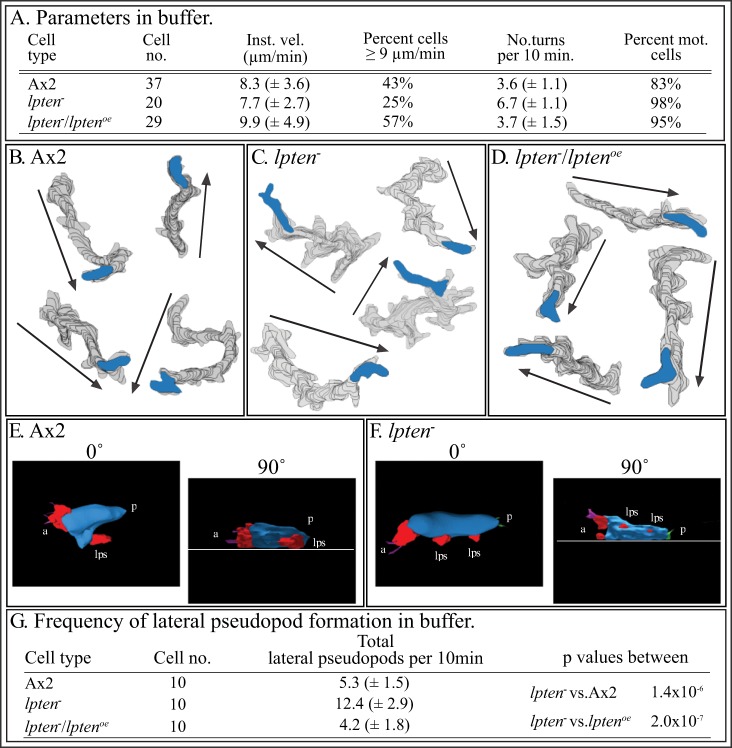

lpten− cells translocating in buffer in the absence of chemoattractant exhibit defects in velocity, turning and the suppression of lateral pseudopod formation.Cells were analyzed in a perfusion chamber through which buffer without attractant was pumped. A. 2D motility parameters of Ax2, lpten− and ptenA−/lptenoe cells assessed with 2D-DIAS software. B, C, D. 2D-DIAS reconstructions of cell perimeters to generate tracks. Arrows denote net direction, and the blue-filled perimeters represent the last cell positions in the tracks. E, F. 3D-DIAS reconstructions at 0° (top view) and 90° (side view) of representative Ax2 and lpten− cells, respectively, denoting pseudopods (red). Note that the multiple lateral pseudopods formed by lpten− cells, were primarily off the substrate. a, anterior end of cell; p, posterior end of cell; lps, lateral pseudopod. G. 2D analysis of lateral pseudopod formation. Inst. vel., instantaneous velocity; No. turns per 10 min., number of turns per 10 minutes; Percent mot. cells, percent motile cells. Parameters are presented as the means ± standard deviations. T-test was used to determine p values. Parameters are defined in Table S2.